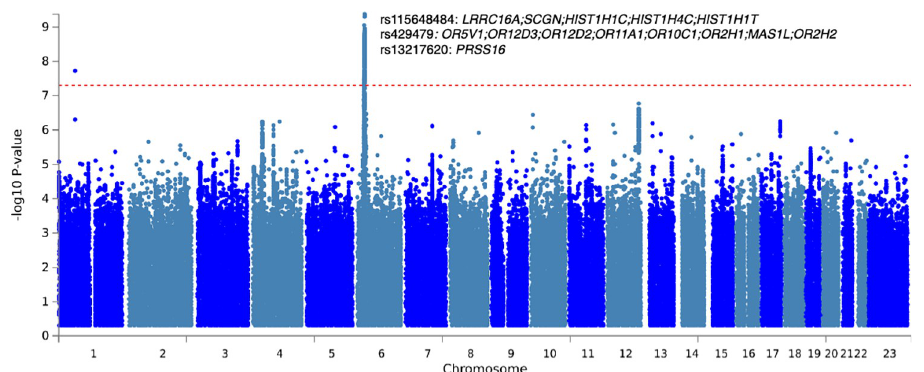
Fig 3. Genome-wide association study on physical activity based accelerated aging: negative log10 (p-value) vs. chromosomal position. Dotted line denotes 5e-8. Genomic control inflation factor (lambda) was 1.04. 3 of the ten11 SNPs found in chromosome 6 are